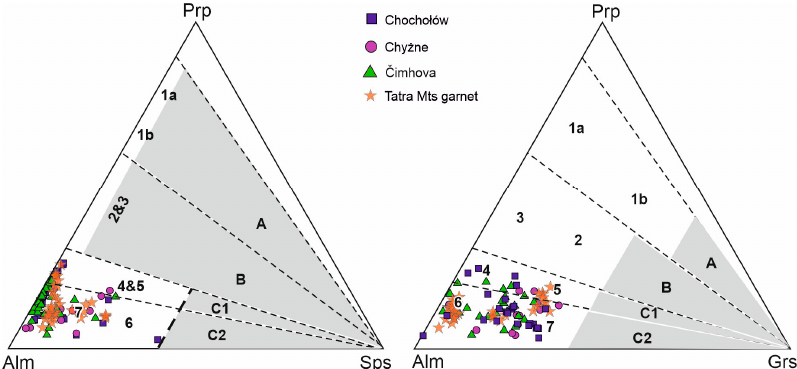
Figure 7. Abundances of morphological types of zircon in the studied deposits from the Orava Basin.